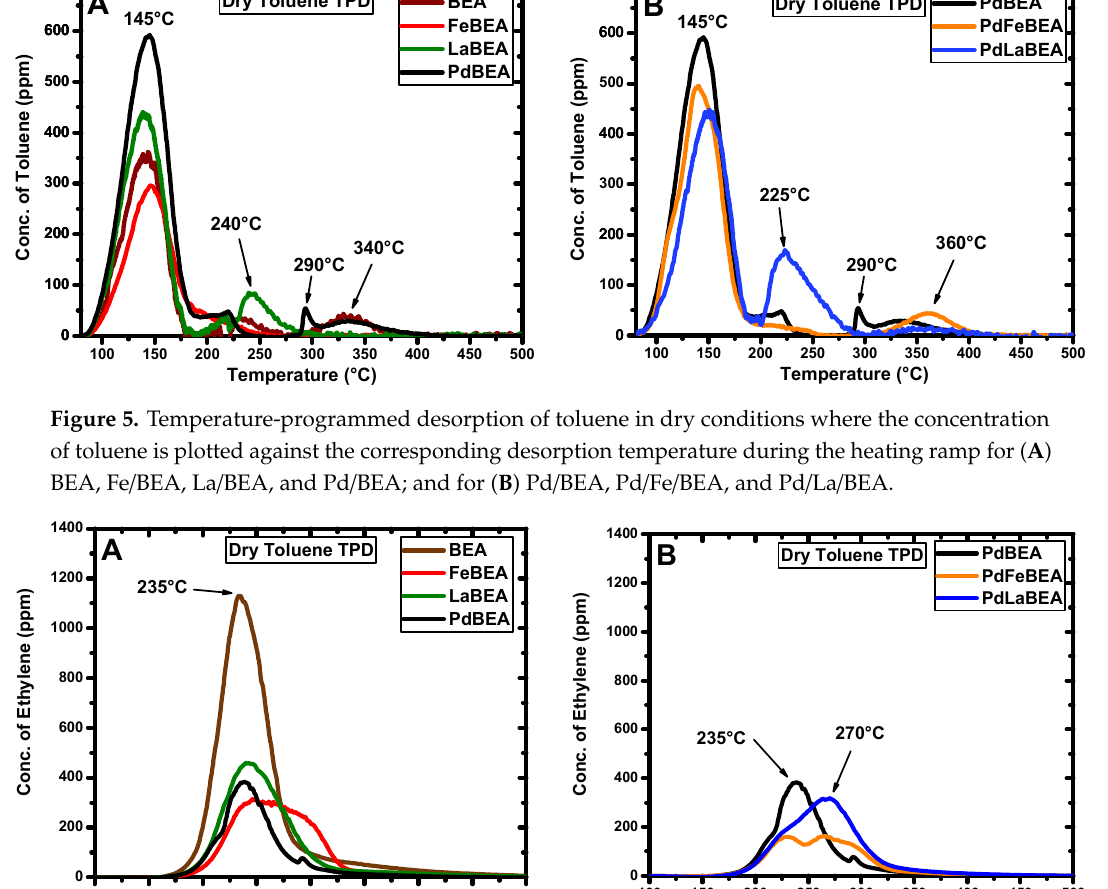
Figure 7. Temperature-programmed desorption of toluene in dry conditions where the concentration of formed CO is plotted against the corresponding temperature for A ) BEA, Fe/BEA, La/BEA, and Pd/BEA; and B ) Pd/BEA, Pd/Fe/BEA, and Pd/La/BEA. Temperature-programmed desorption of toluene in wet conditions was performed to investigate the capacity of the samples to store toluene in a more realistic environment, since water vapor is naturally formed during the combustion of hydrocarbon-based fuels. The wet toleune-TPD